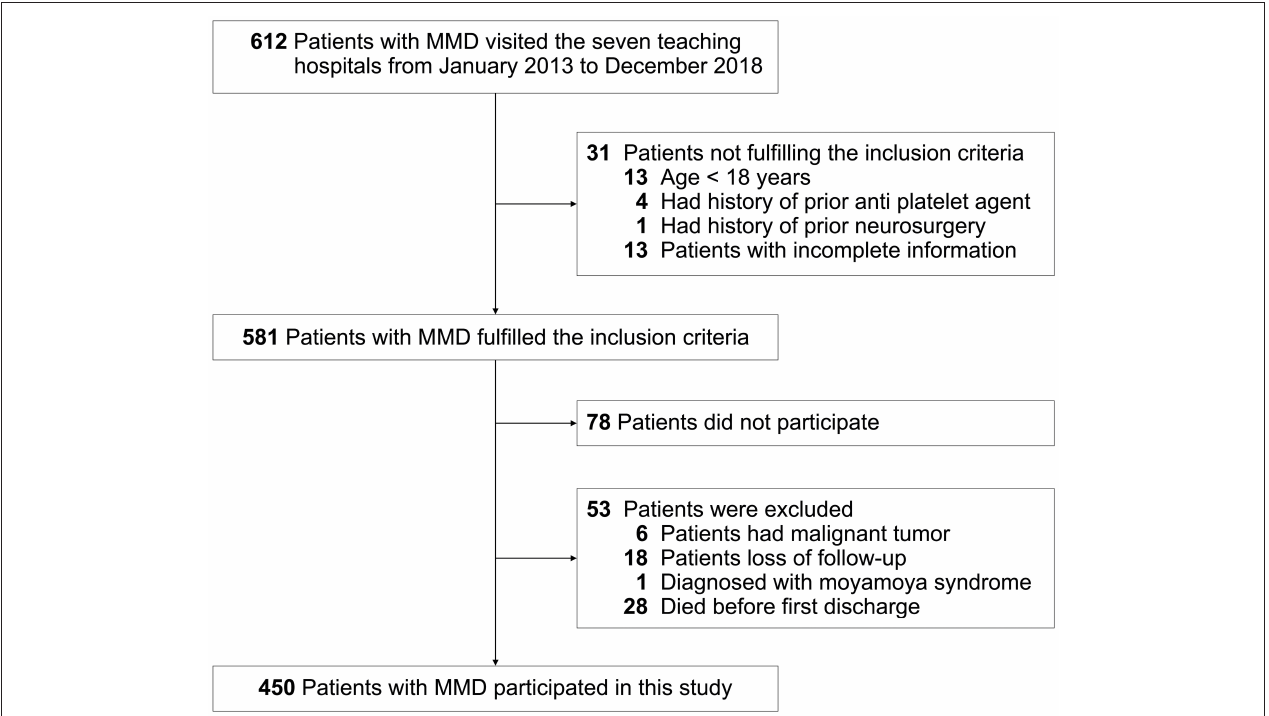
FIGURE 1 | Flow chart presenting the process of patient inclusion and exclusion in this